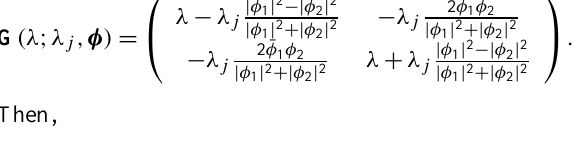
Figure 10. Evolution of A ( 1 , 2 )